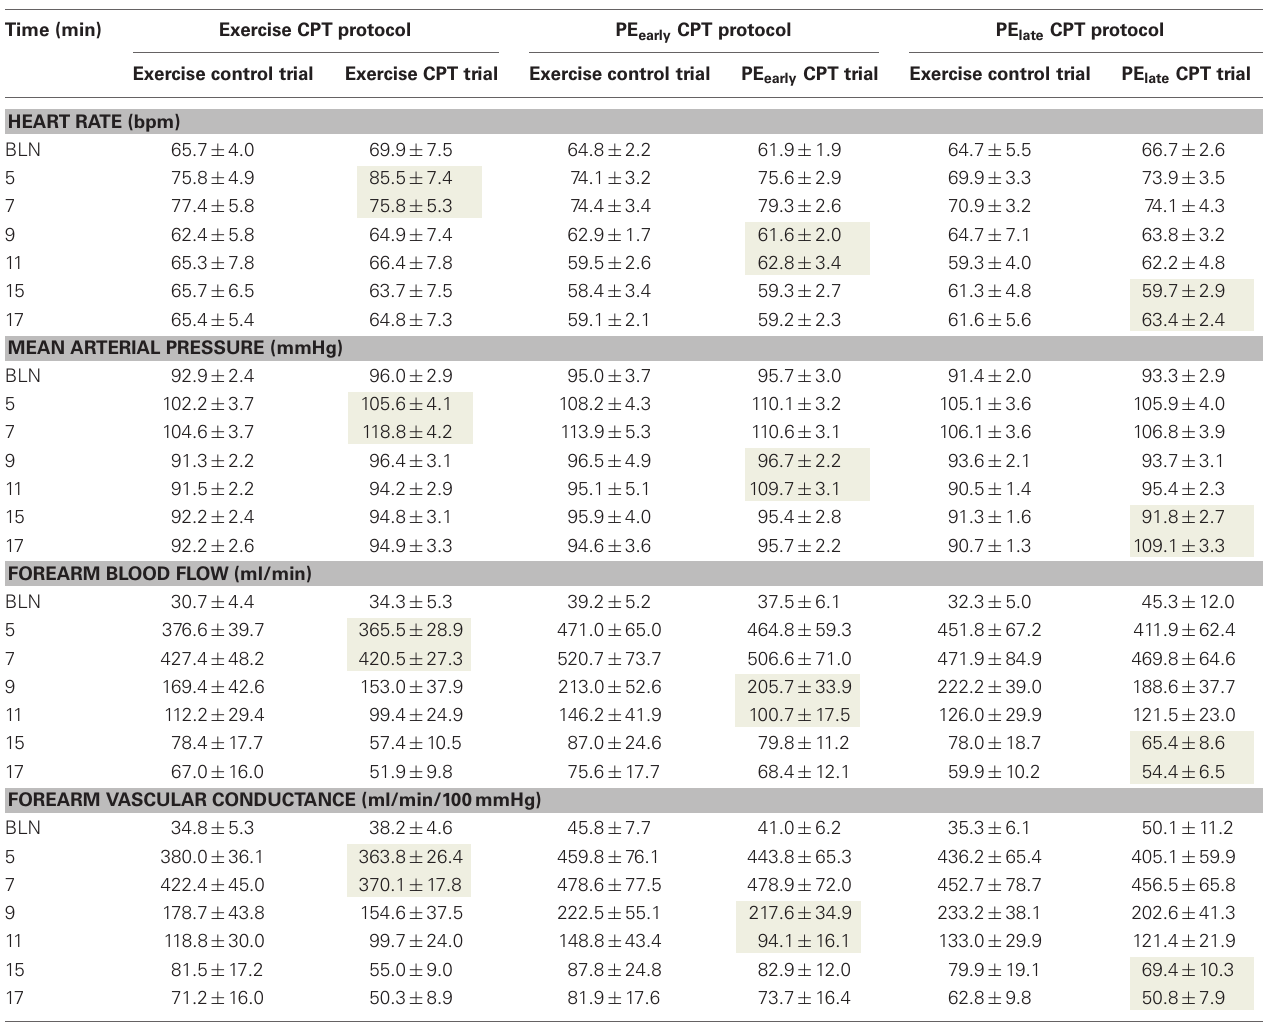
Table 3 | Absolute hemodynamic responses at all time-points during Trial B–E (see Figure